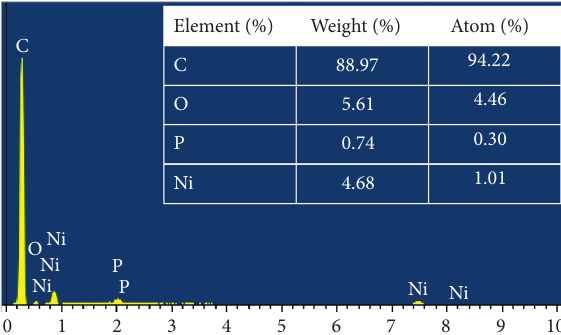
2 P-Ni 12 P 5 /CW.